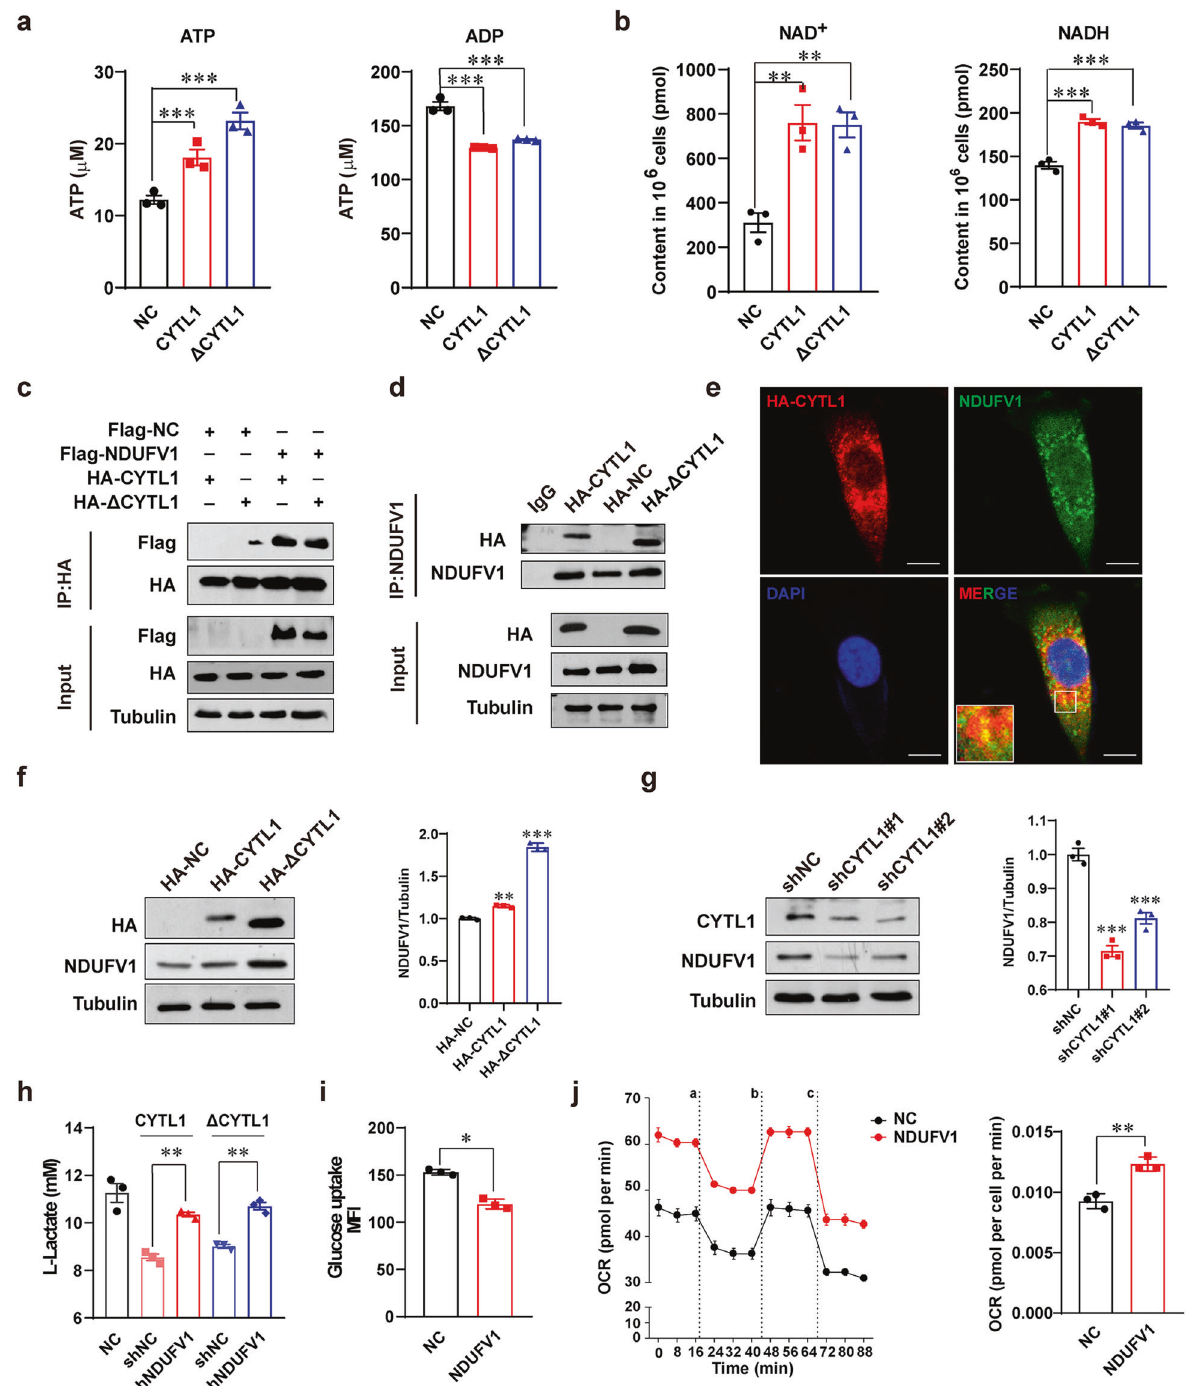
Fig. 4 Intracellular CYTL1 interacts with NDUFV1 and positively regulates its protein expression. a ATP and ADP levels and b NAD + and NADH levels in the cell lysates from MDA-MB-231 cells stably expressing CYTL1 or Δ CYTL1 were determined using kit assays. c Co-IP analysis of the interaction between exogenous HA-CYTL1 or HA- Δ CYTL1 and exogenous Flag-NDUFV1 in transfected HEK293T cells. d Co-IP analysis of the interaction between endogenous NDUFV1 and exogenous HA-CYTL1 or HA- Δ CYTL1 in transfected HEK293T cells. IgG served as the negative control. Tubulin was used as a loading control. e Colocalization of HA-CYTL1 and endogenous NDUFV1 was detected by Immuno fl uorescence in transfected HEK293T cells. Scale bar, 5 μ m. f , g NDUFV1 protein expression was determined by western blot in MDA- MB-231 cells transfected with f HA-CYTL1 or HA- Δ CYTL1 expressing plasmids or g the indicated shRNAs. Tubulin was used as a loading control. h Lactate production levels in CYTL1 or Δ CYTL1 overexpressing MDA-MB-231 cells cotransfected with the indicated shRNAs. i Glucose-uptake activity and j the OCR in MDA-MB-231 cells overexpressing NDUFV1. The data are shown as the mean ± SD of three independent experiments. * P < 0.05, ** P < 0.01, *** P < 0.001